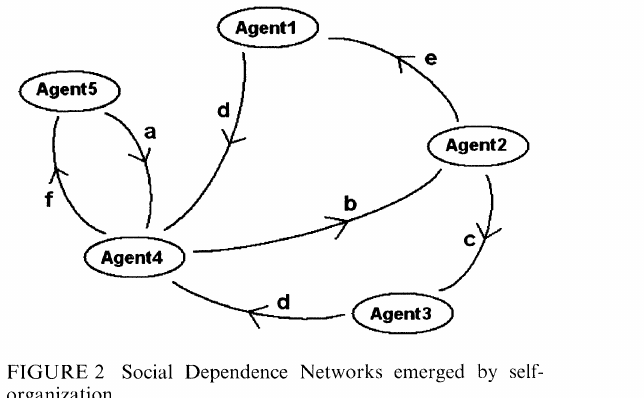
FIGURE 2 Social Dependence Networks emerged by self-